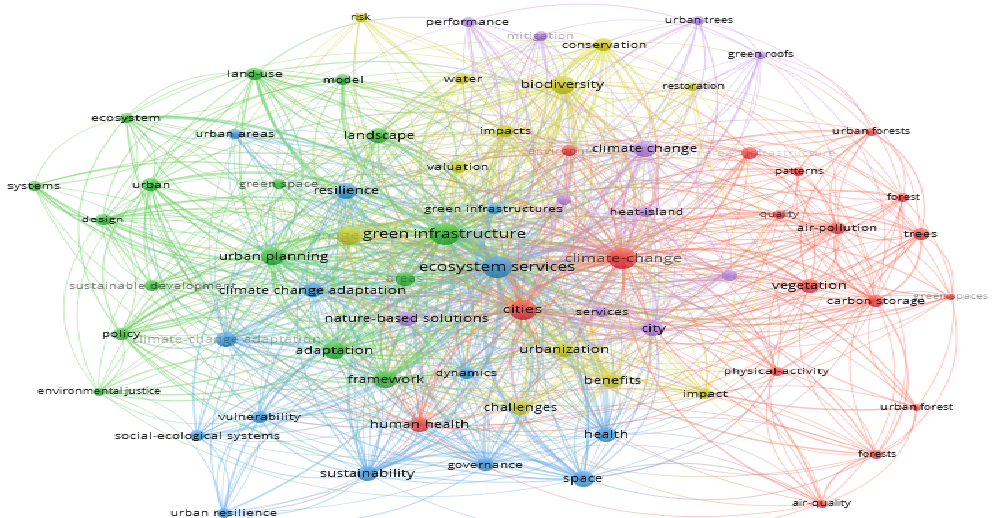
Figure 3. Visualization of Cluster Network of all Keywords Source: VOSviewer . Own Compilation. Cluster 1 (green) This cluster is closely related to the concept of urban green infra- structures and the need to reconnect more than half the planet’s population living in urban areas with the biosphere [27].